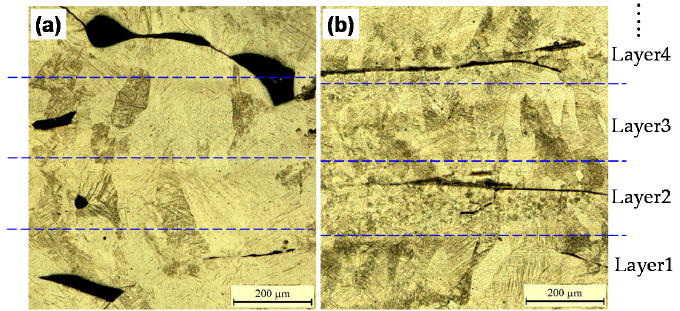
Figure 4. Optical microscopy (OM) images showing the typical macrostructure of ( a ) of SLM sample with defects and ( b ) UIT assisted SLM sample with defects, the hatch spacing of two samples is 0.8